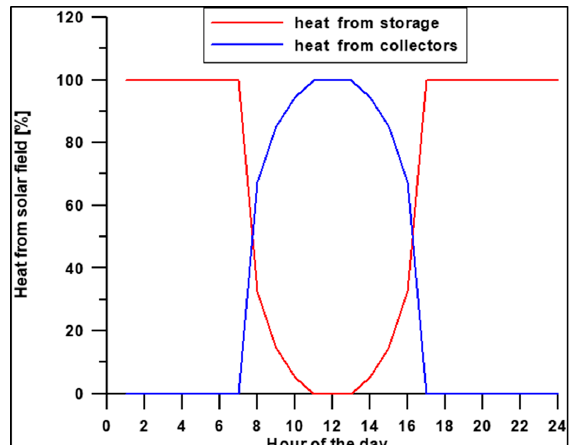
Figure 3. Percentage of heat to network from solar field.